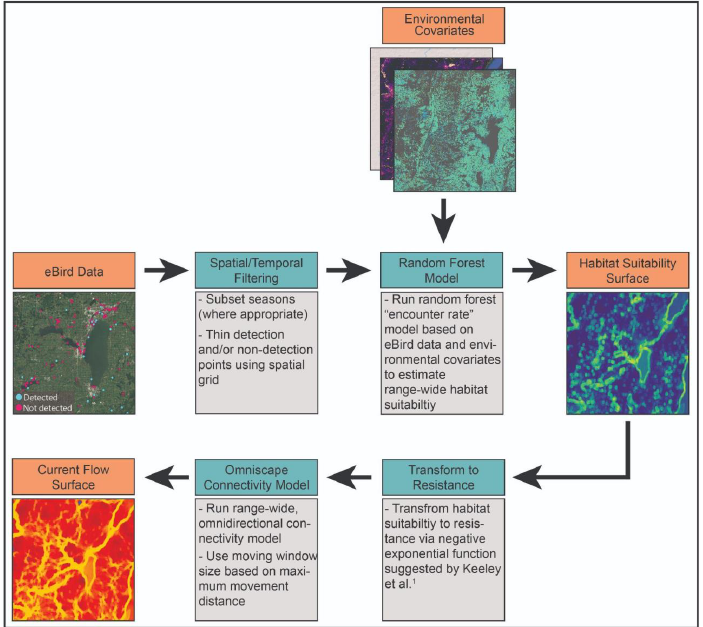
Figure 1. Analysis workflow, applied to each of the three focal species (Greater Sage-Grouse, Amer- ican Black Duck, and Bobolink). Orange boxes denote data inputs and/or outputs. Blue boxes denote data processing or modeling steps. 1 Keeley et al. [33].